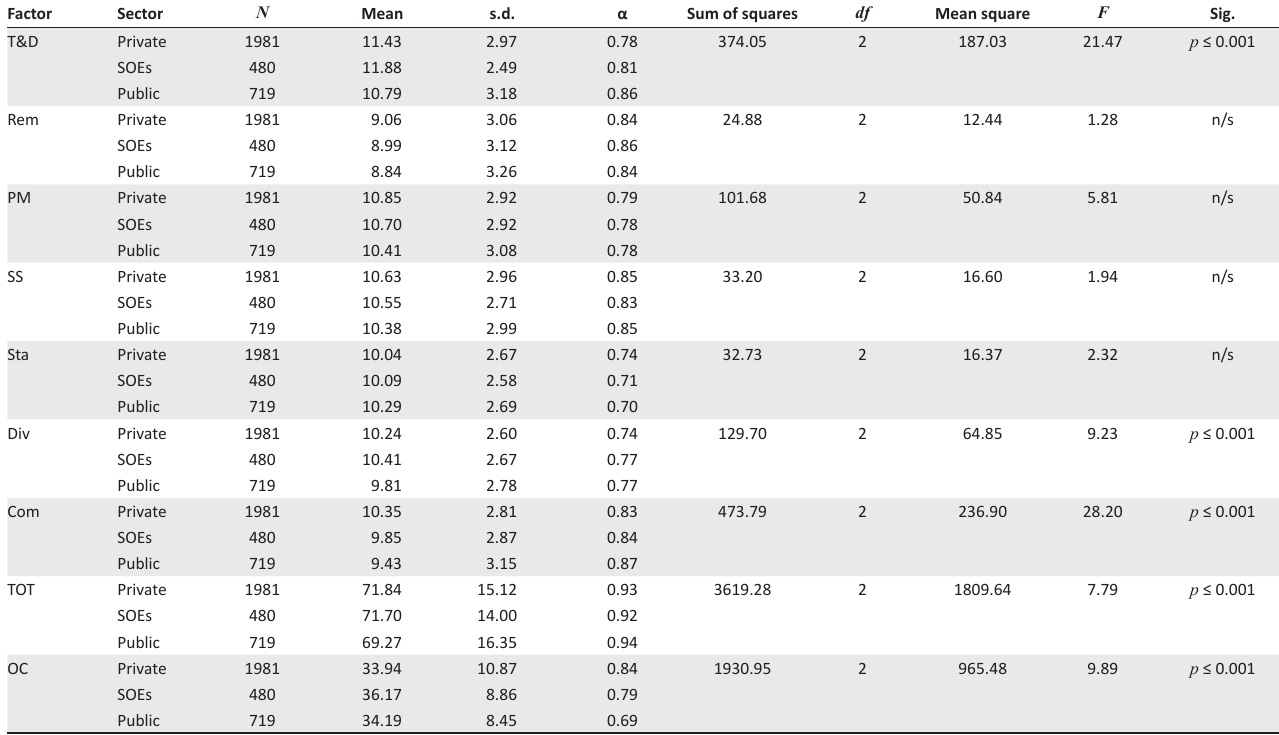
TABLE 2: Means, reliability and test of mean differences (ANOVA).